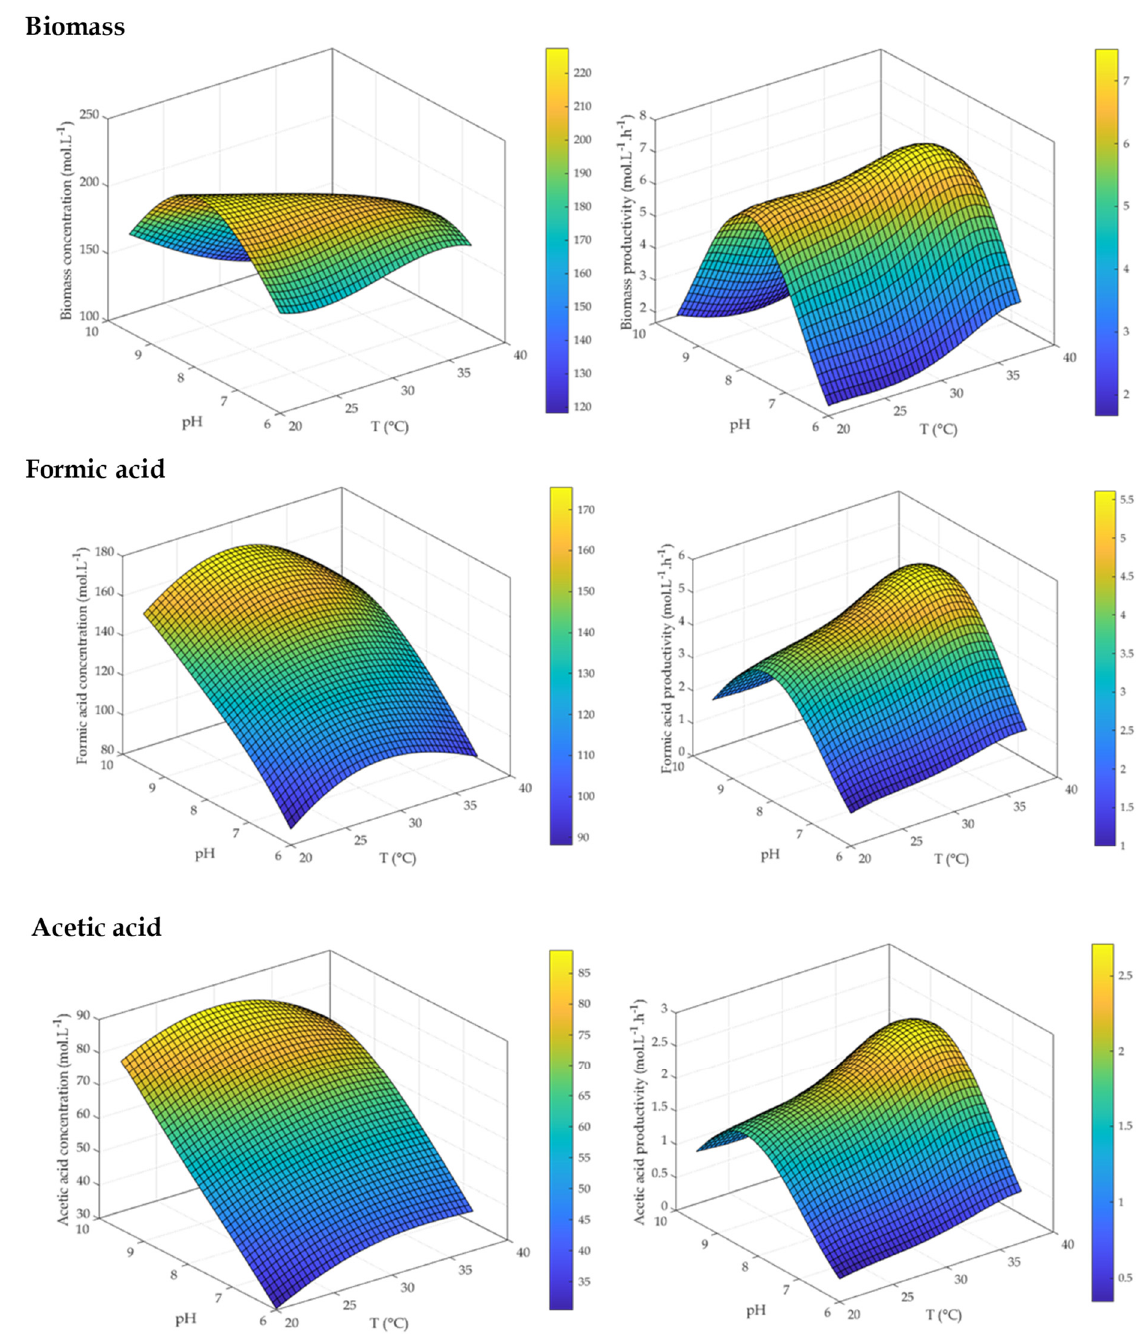
Figure A2. Evolution of final concentrations (left) and batch-average productivities (right) with temperature and pH for biomass, formic acid, and acetic acid.